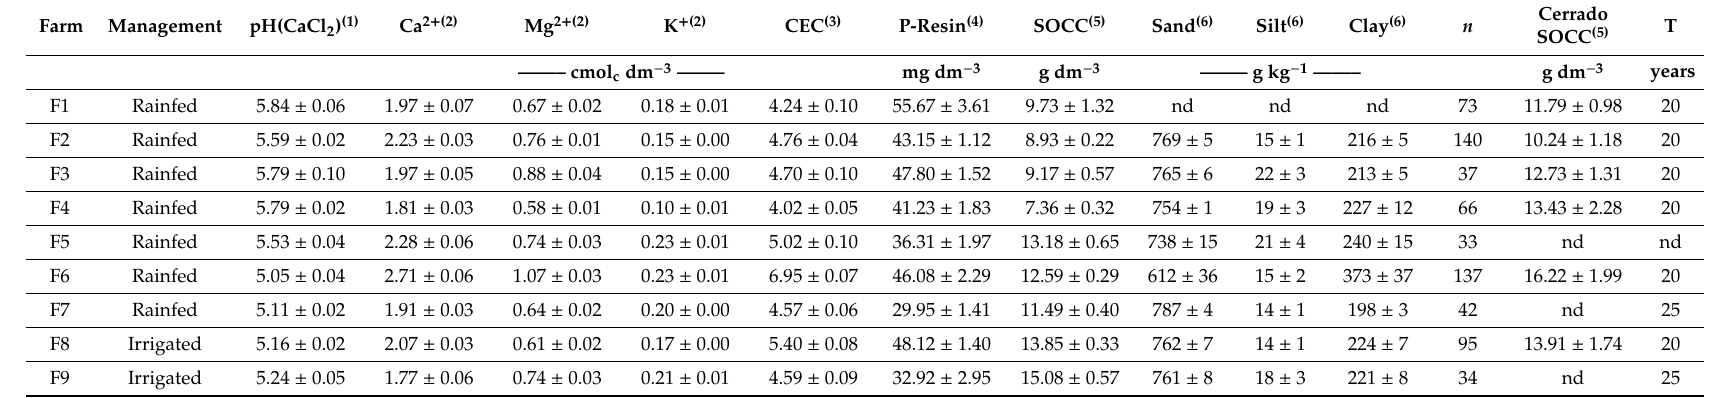
Table 1. Average chemical and physical properties of the nine